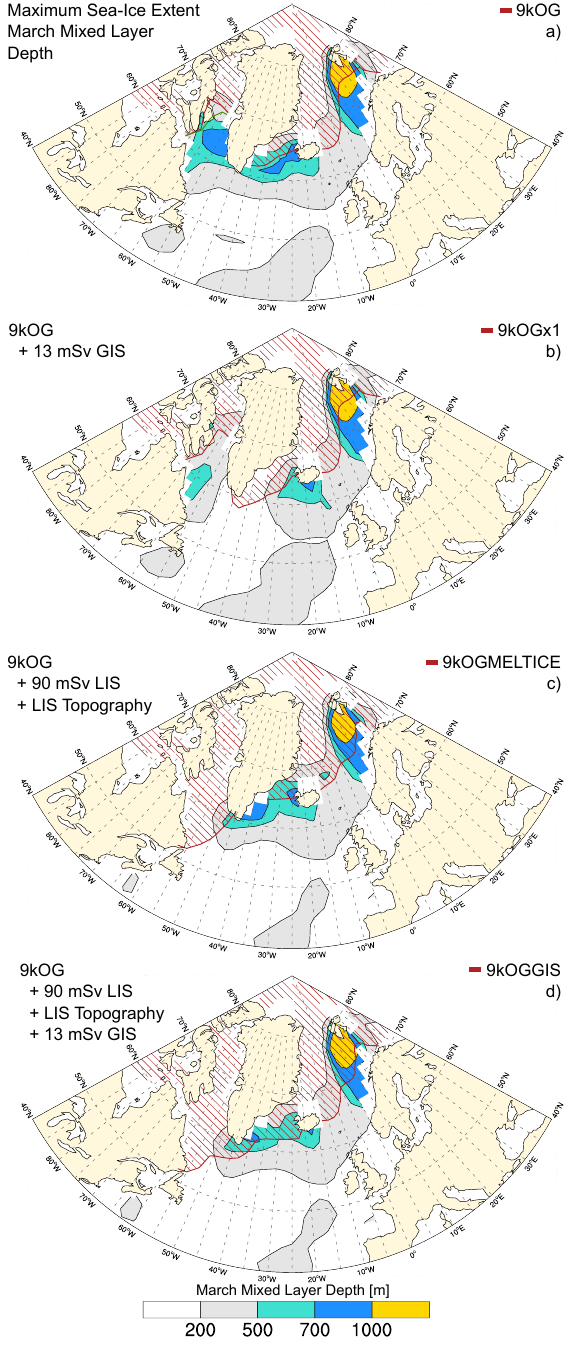
Fig. 5. March mixed layer depth (MMLD, in metres) and win- ter maximum sea ice concentration (SIC) over 15%, denoting sea ice extent. Values are calculated from the last 100yr of each ex- periment. (a) shows MMLDs for simulation 9kOG and SIC for simulation 9kOG. (b) shows MMLDs for simulation 9kOGx1 and SIC. (c) shows MMLDs for simulation 9kOGMELTICE and SIC. (d) shows MMLDs for simulation 9kOGGIS and